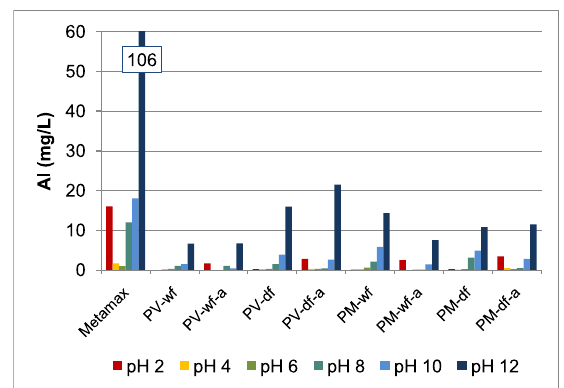
Figure 7. Leaching of aluminum at different pH values.